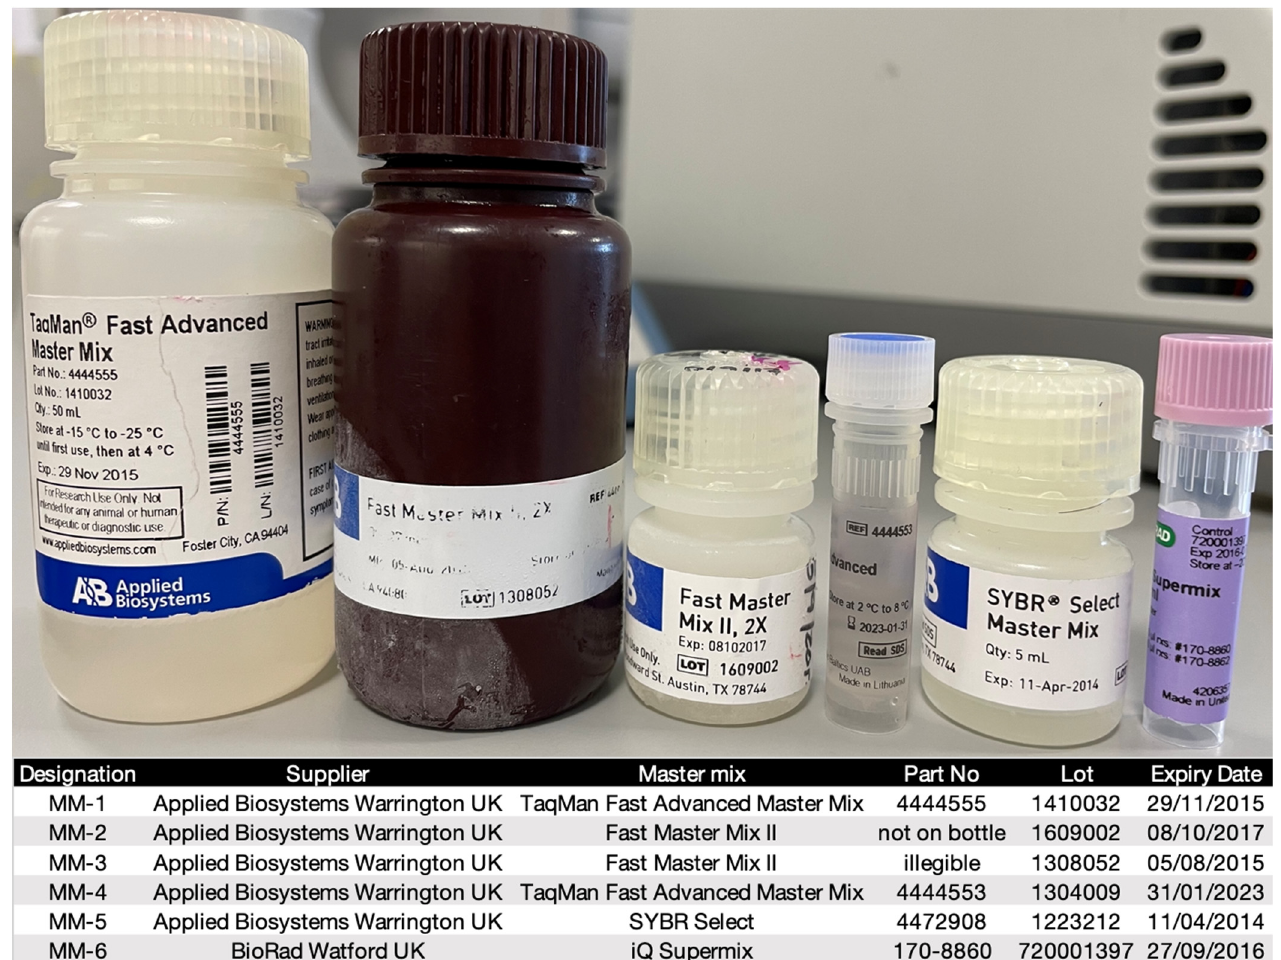
Figure 8. The six master mixes tested for past expiry date performance, with expiration dates. Details of additional master mixes and the three qPCR instruments used are listed in Figure 1A.